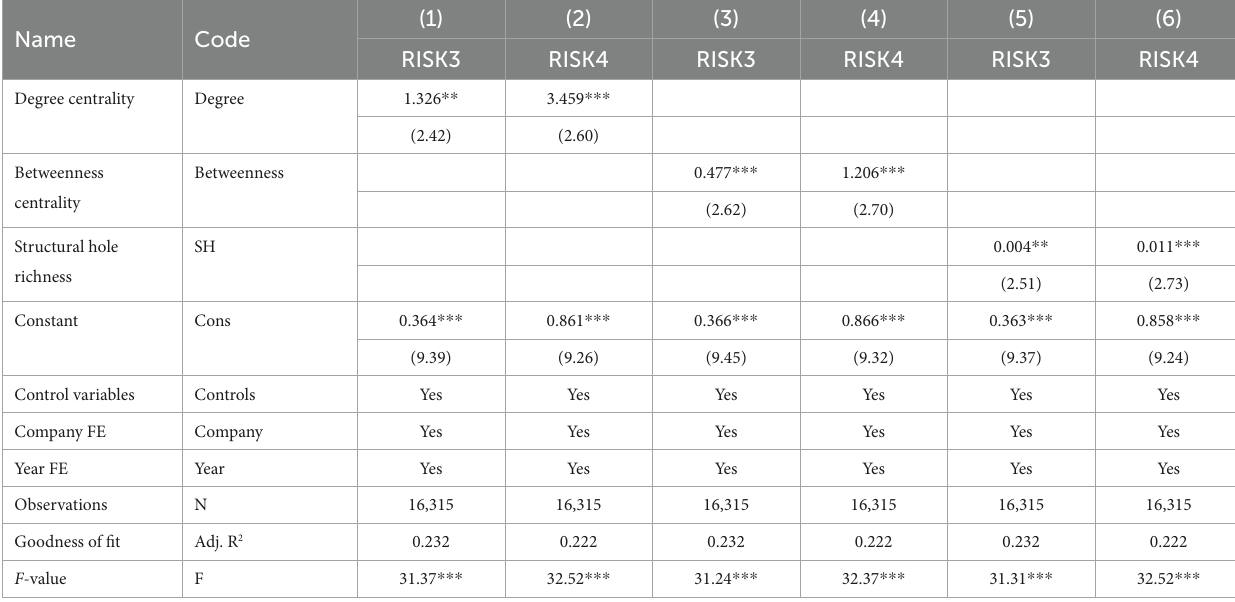
TABLE 6 Indicator sensitivity test: changing the observation period.